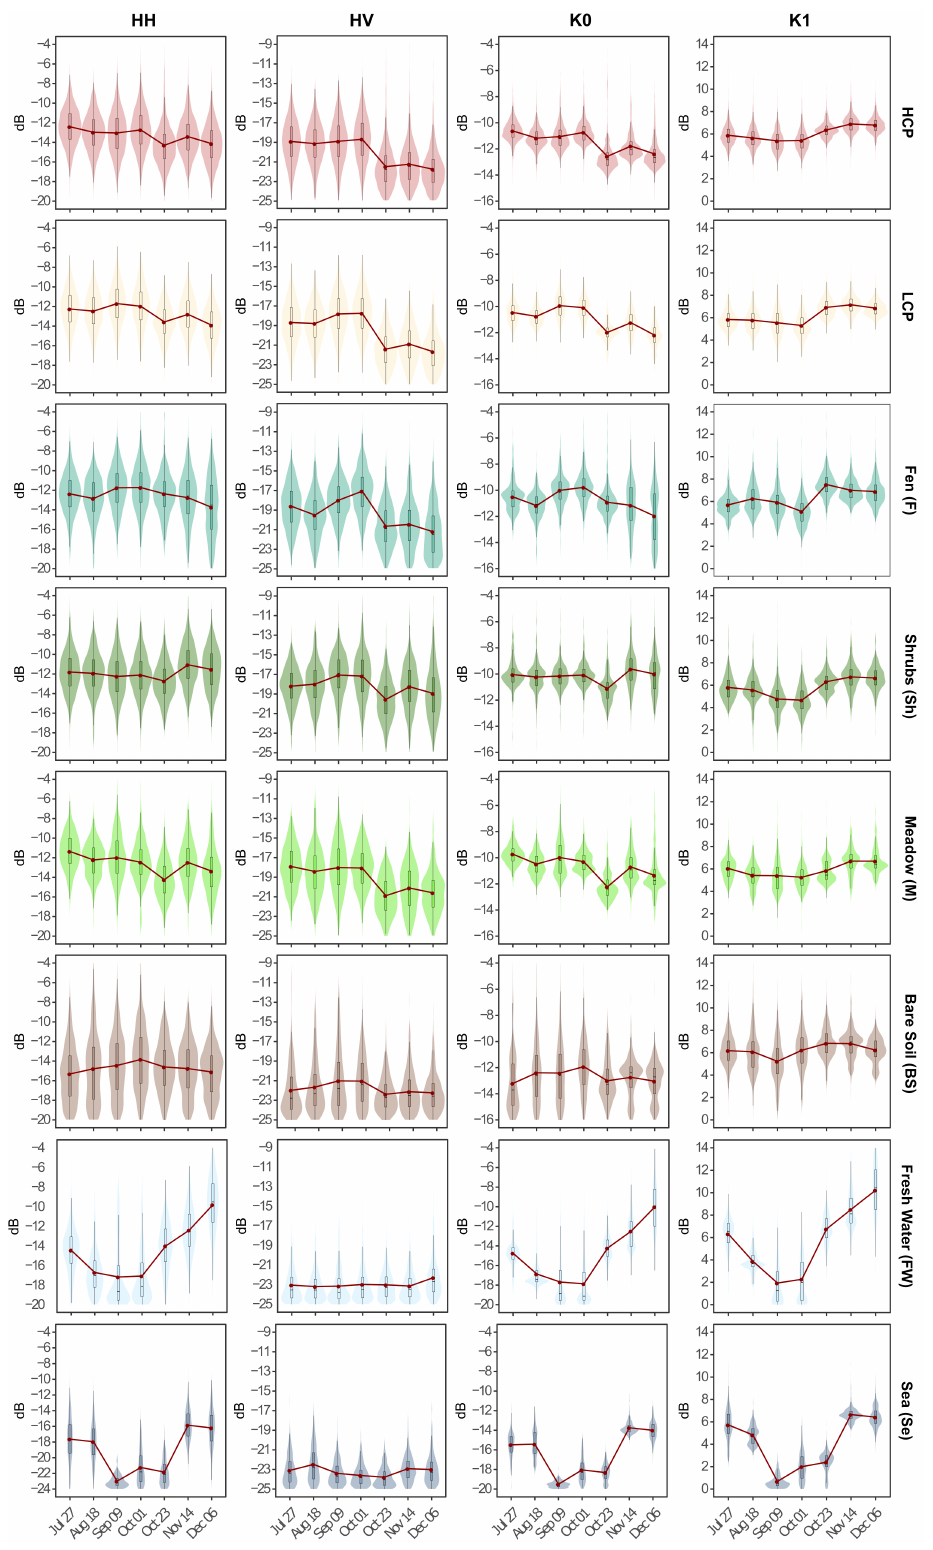
Figure 5. Violin plots for each TerraSAR-X acquisition date of the HH and HV Sigma Nought intensity values and the K 0 and K 1 Kennaugh element values grouped by land cover class. The box plots display minimum, lower quartile, median, upper quartile, and maximum. The red line connects the mean value for each acquisition date. The recorded periods are: peak-level vegetation (27 July and 18 August); senescence (9 September and 1 October); and snow cover (23 October, 14 November, and 6